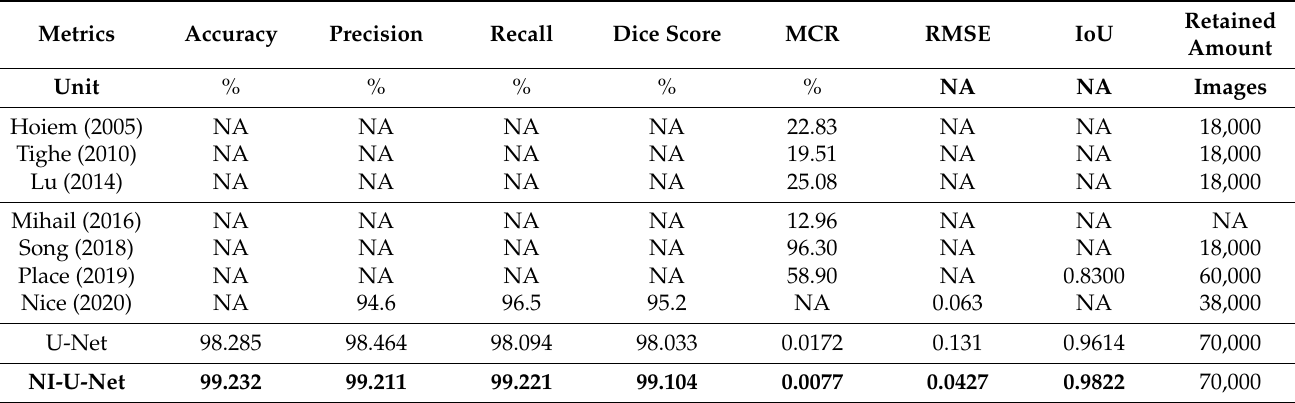
The bold contexts refer to the best value in the corresponding metric. “Hoiem”, “Tighe”, and “Lu” refer to the baseline results provided in [26], respectively. Mihail, Song, Place, and Nice refer to the recent advanced results in [26,31,34,35], respectively. The “U-Net” refers to the results from the re-implemented U-Net. The “NI-U-Net” refers to the pre-trained results from this research. The symbol “NA” refers to either not applicable or not available.